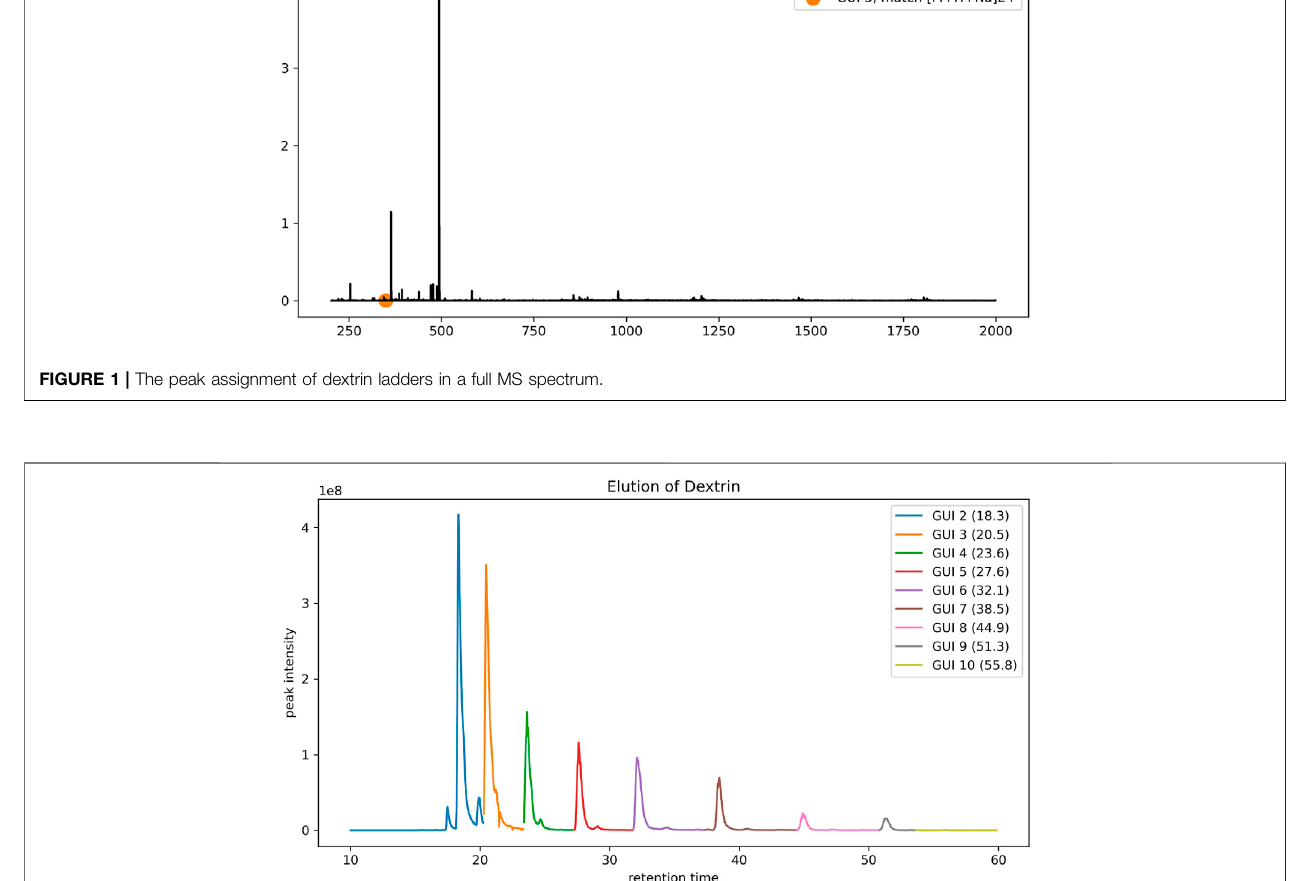
Frontiers in Chemistry |